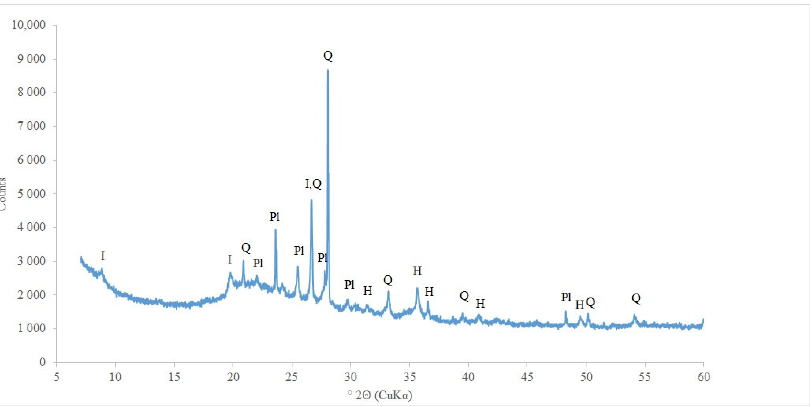
Figure 9. XRD pattern of commercial oil adsorbent (I—illite, Q—quartz, Pl—plagioclase, H—hematite).